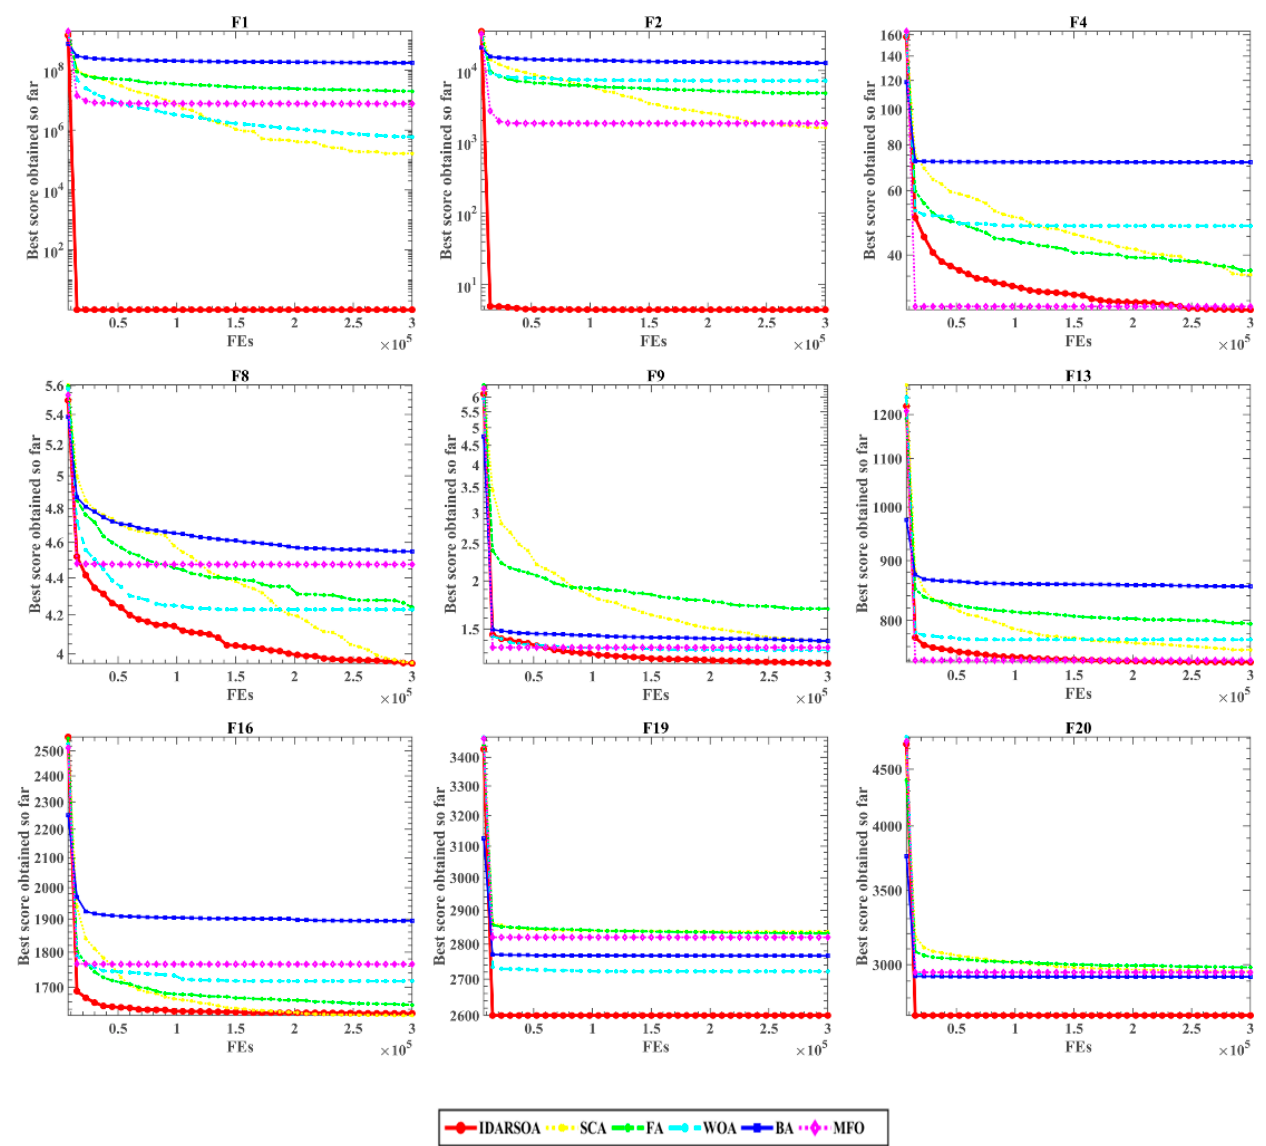
Figure 5. Convergence curve of IDARSOA and original algorithms.